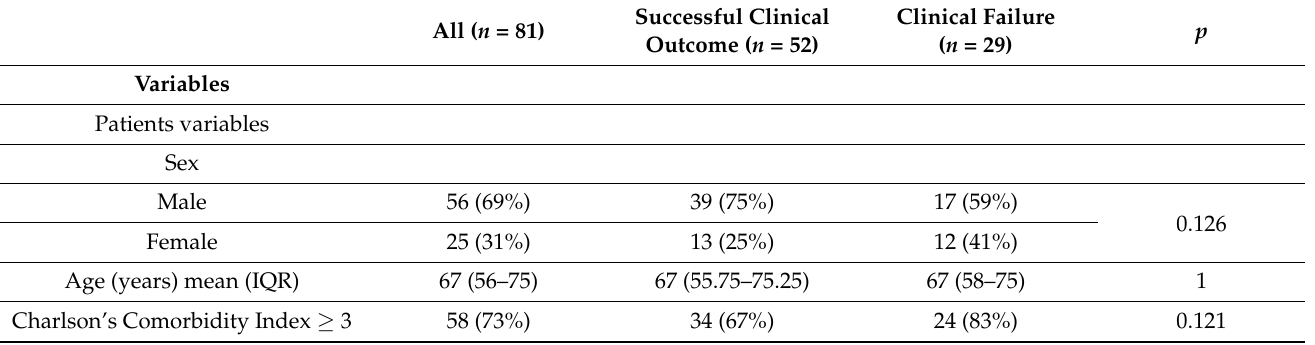
Table 1. Demographic and clinical characteristics of the study